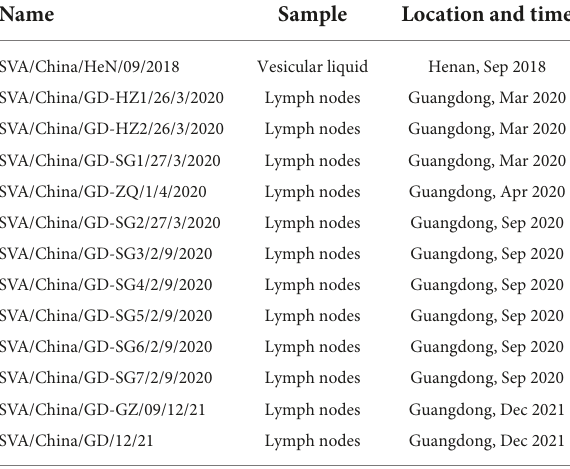
TABLE 1 Information on the 10 lab-isolated SVA strains.